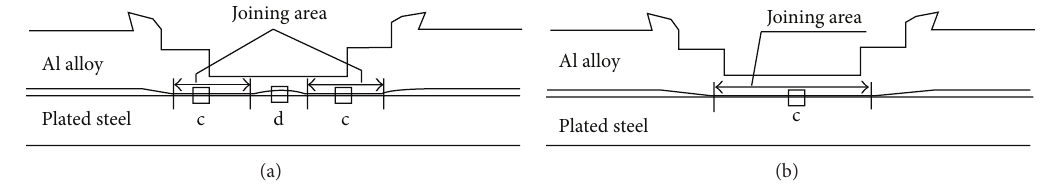
Figure 8: Schematic illustration of the joint interface: (a) ZAM and GI, (b) AS and GA [26].